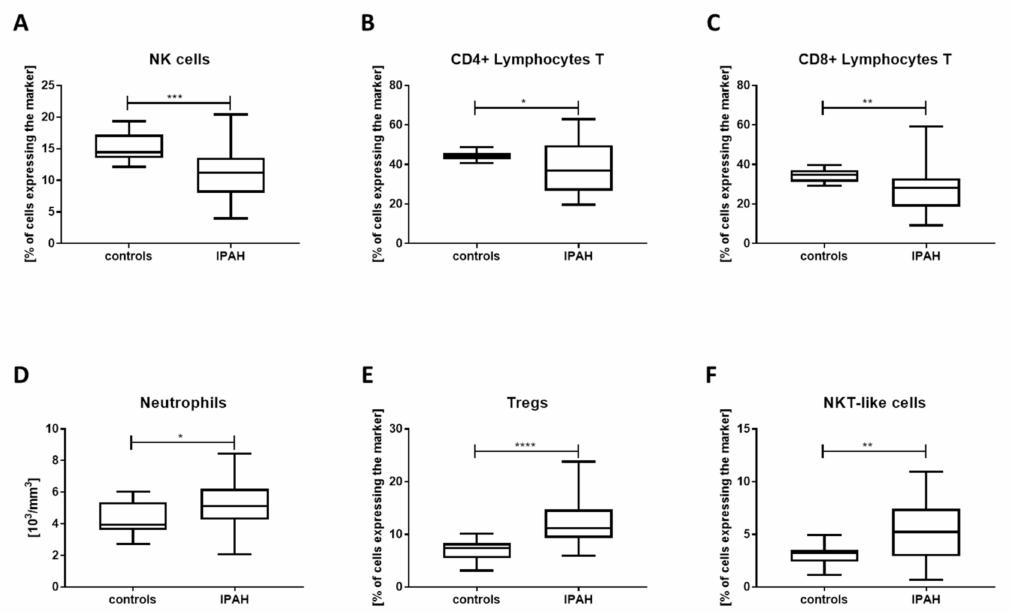
Figure 1. Idiopathic pulmonary arterial hypertension (IPAH) patients display altered cellular composition of the peripheral blood. Peripheral blood cells were immunophenotyped using flow cytometry, and specific cell populations were quantified. Data are presented as percentage of total leukocytes(CD45 + cells)ortheabsolutecellcountinthebloodforneutrophils. Graphsshowcomparison of IPAH patients’ results and corresponding healthy controls. There is a significant decrease in the proportions of ( A ) NK cells, as well as ( B ) CD4 + and ( C ) CD8 + T cells in the patients, as compared to controls. Moreover, ratios of ( D ) neutrophils, ( E ) T regs, and ( F ) NKT-like cells are augmented. Horizontal bars represent medians; boxes overlap 25th to 75th percentiles, and whiskers extend from minimum to maximum. In the figure, * denotes p ≤ 0.05, ** p ≤ 0.01, *** p ≤ 0.001, and **** p ≤